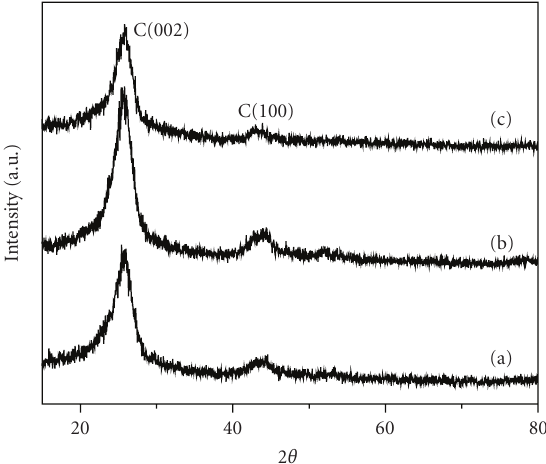
Figure 2: Representative powder XRD pattern for the catalyst 25% Co + 25% Ni on MgO support.